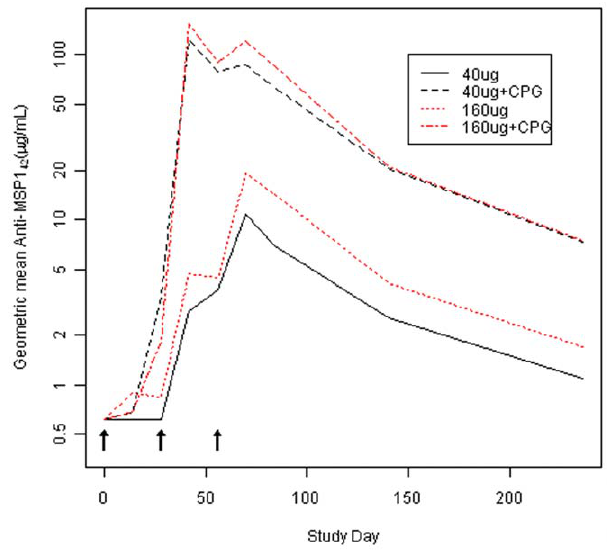
Figure 2. Geometric means and 95% confidence intervals of antibody in each group, as measured by ELISA and calculated from the arithmetic mean of anti-MSP1 42 -FVO and anti- MSP1 42 -3D7 ELISA results.